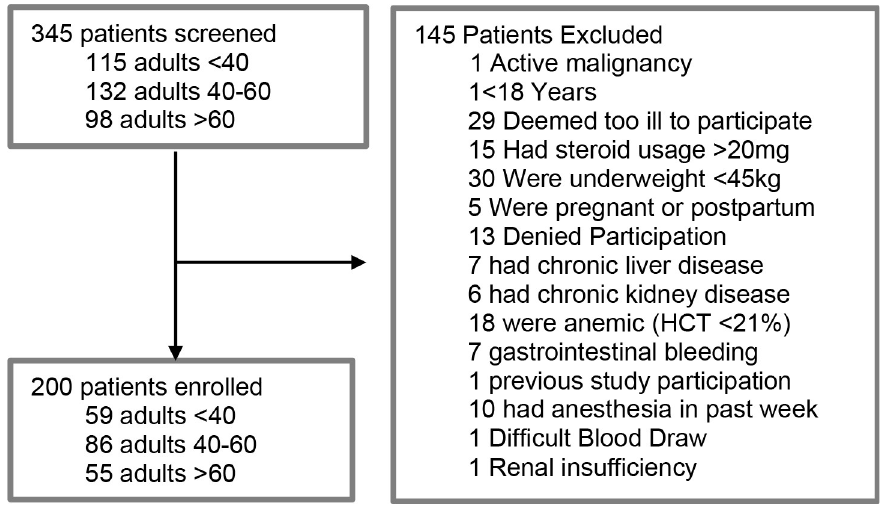
Fig 1. Schematic representation of study